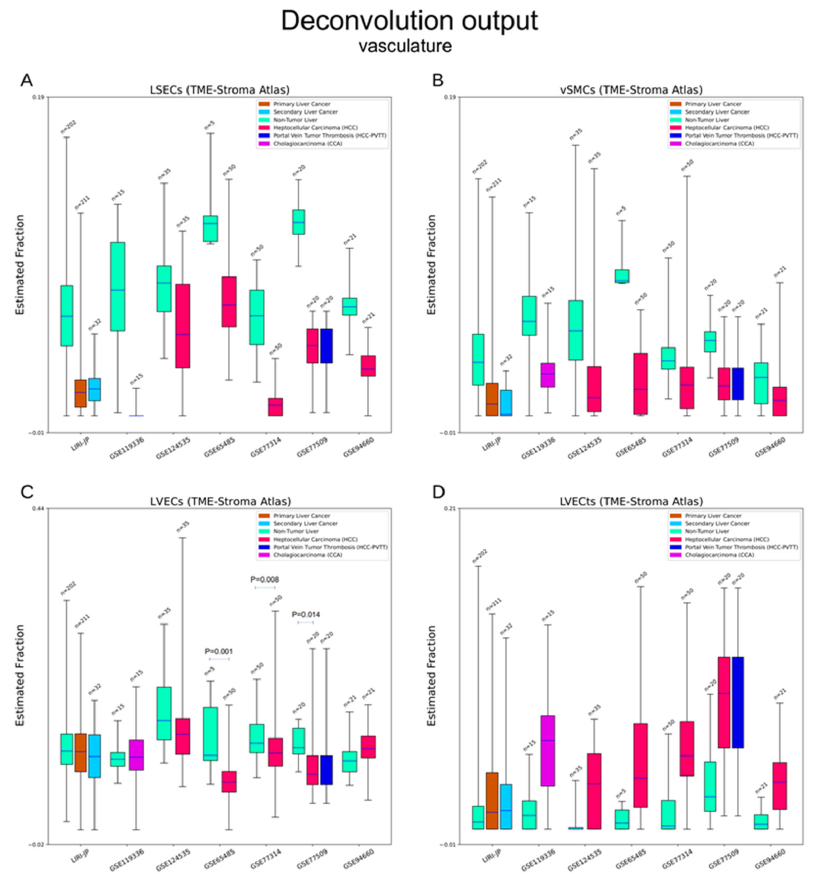
Figure 3. Deconvolution output—vasculature. ( A – D ) Estimation of liver sinusoidal endothelial cells (LSECs), vascular smooth muscle cells (vSMCs), liver vascular endothelial cells (LVECs), and tu-